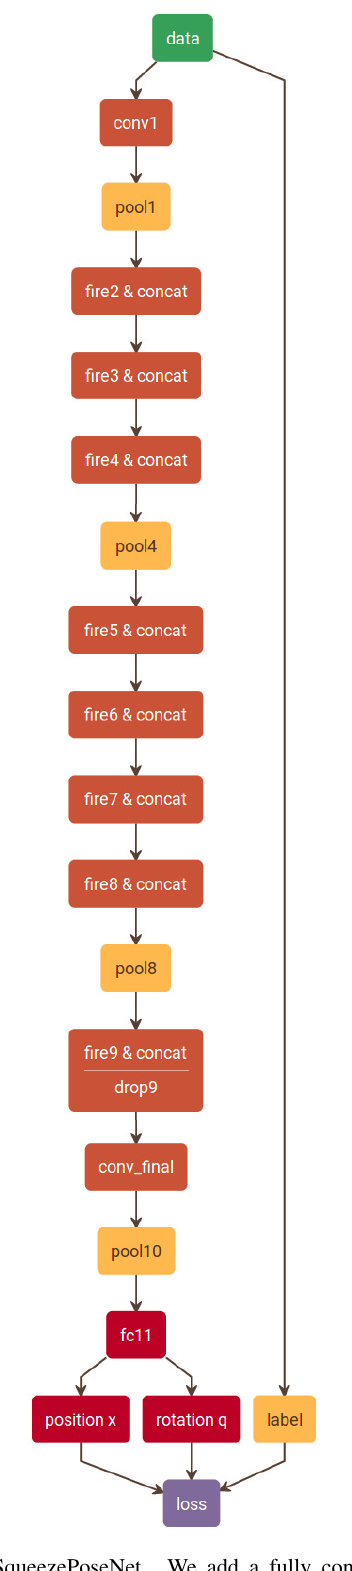
Figure 1. SqueezePoseNet. We add a fully connected layer (’fc11’) with 500 neurons. For pose estimation we added two dense layers (’ x ’ and ’ q ’) with 3 respectively 4 neurons. All weighting parameters up to the ’pool10’-layer are initialized from a pre-trained version of SqueezeNet that was trained on a subset of the Places365 data set (Zhou et al., 2016). The additional lay- ers are pre-trained using the Shop Fac¸ade data set and later on our test set of the Atrium